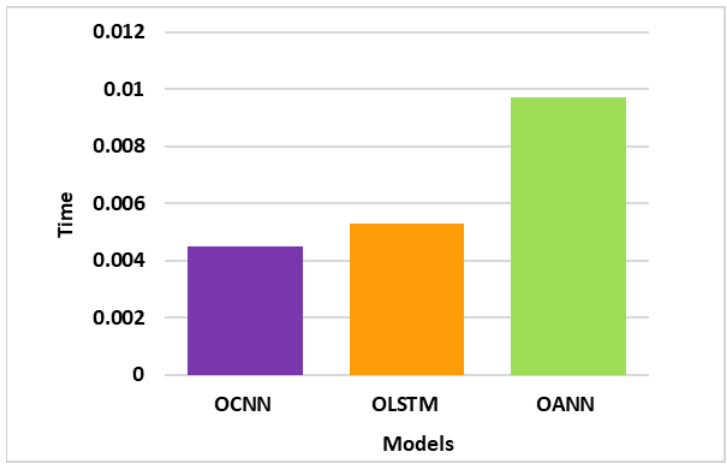
Figure 6. Runtime analysis among the models.4.7. Evaluation of Prediction Result.